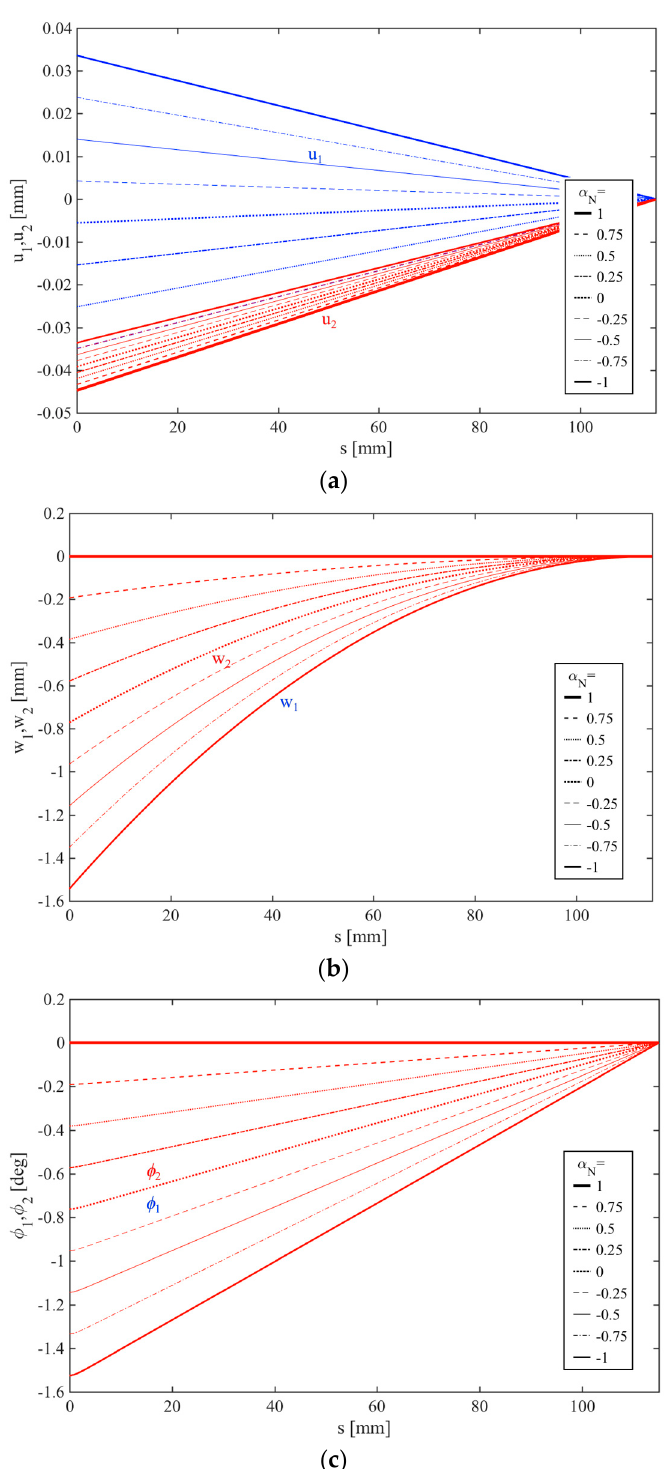
Figure 5. Effect of the axial loading on the kinematic response of the sublaminates: ( a ) Axial displacement; ( b ) Shear displacement; ( c ) Cross-sectional rotation. (Isotropic specimen).